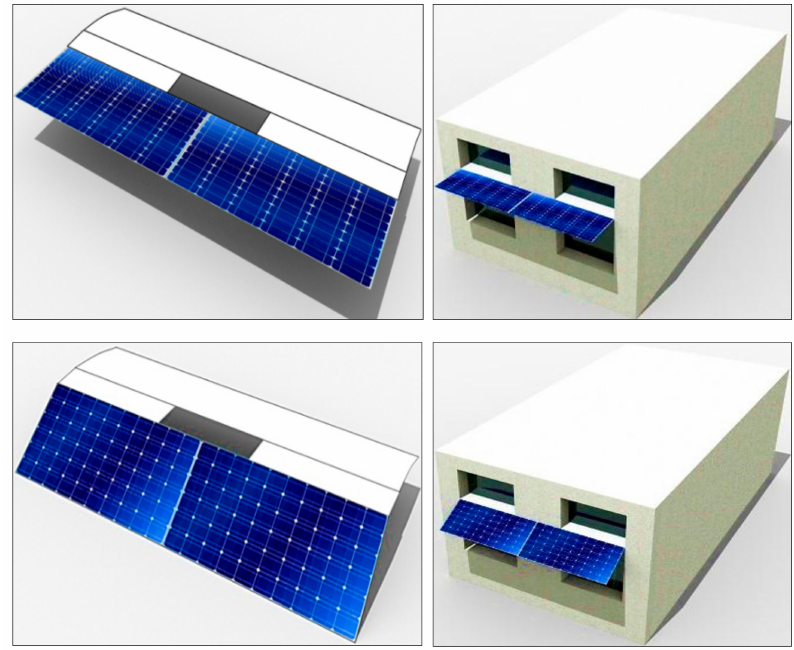
Figure A3. The optimum LSPV configuration